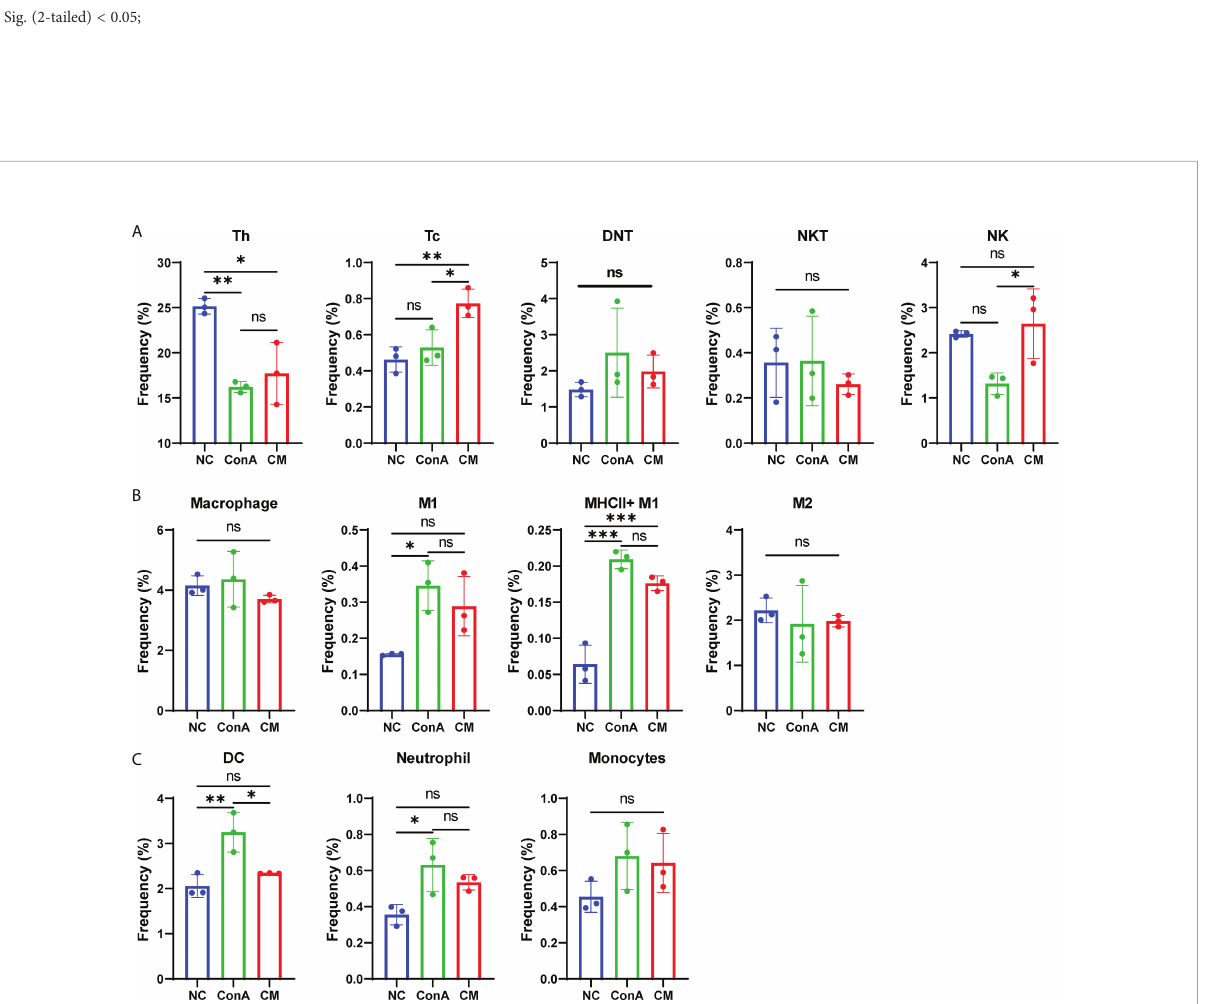
FIGURE 6 Changes in immune cells in mouse spleen tissue. (A) The frequency of Th, Tc, DNT, NKT, and NK cells; (B) the frequency of macrophage, M1, MHCII + M1, and M2 cells; (C) the frequency of DC cells, neutrophil, and monocytes among NC, ConA, and CM groups (n = 3 per group; ns, not statistically signi fi cant, * p < 0.05, ** p < 0.01, *** p < 0.001). Data are presented as mean ±